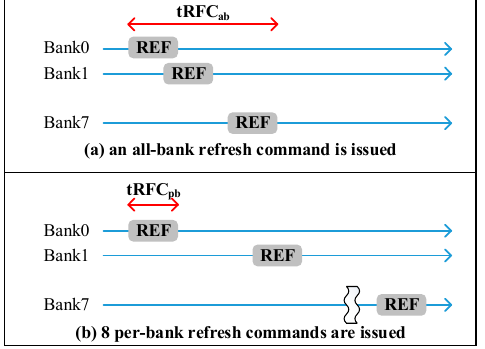
Figure 4. Comparisons of an all-bank refresh and per-bank refresh.